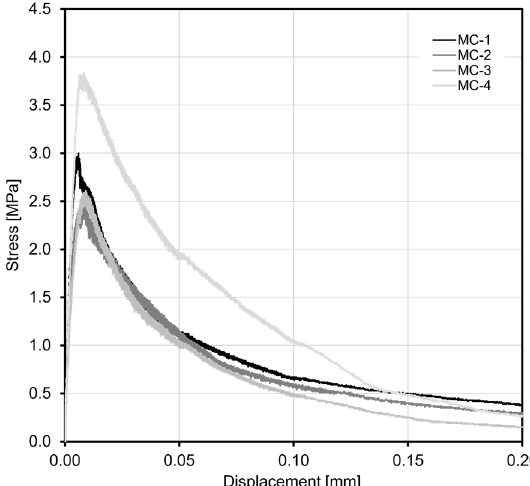
Figure 7. Stress ‐ displacement relations for the mother concrete (MC) specimens.